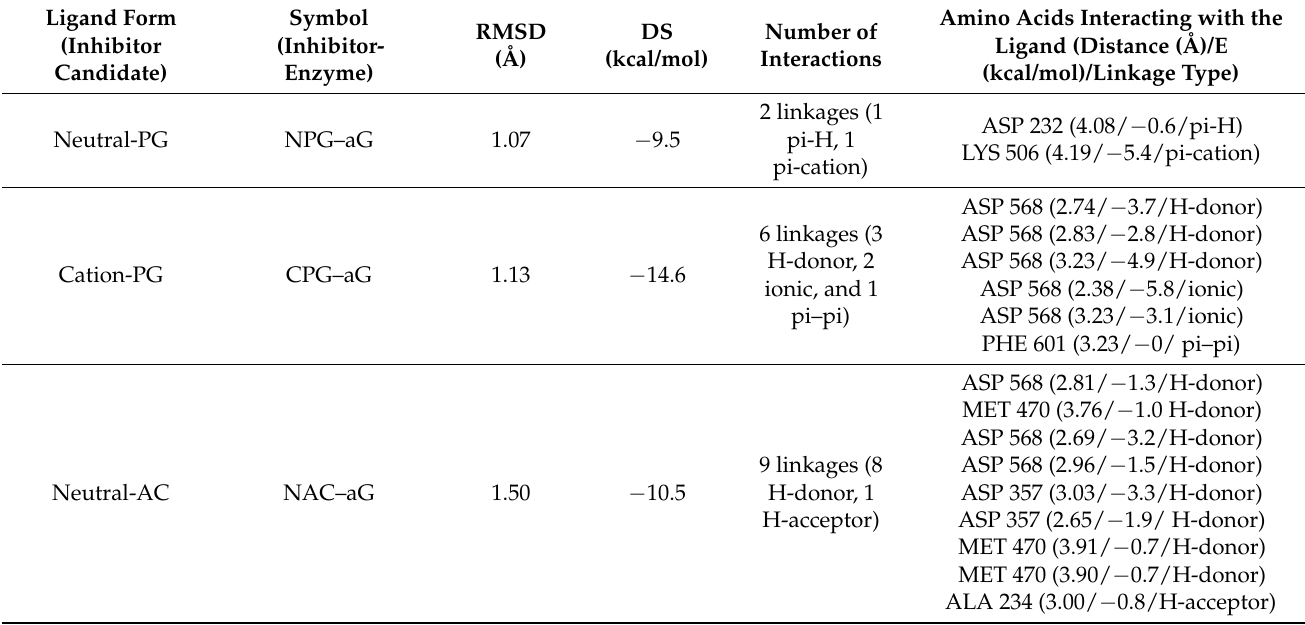
Figure 7. The 2-D and 3-D structures of neutral-PG ( a ), cation-PG ( b ), neutral-AC ( c ), and the α -glucosidase enzyme’s crystal structure ( d ). Table 4. The docking simulation results of ligand binding with target enzyme α